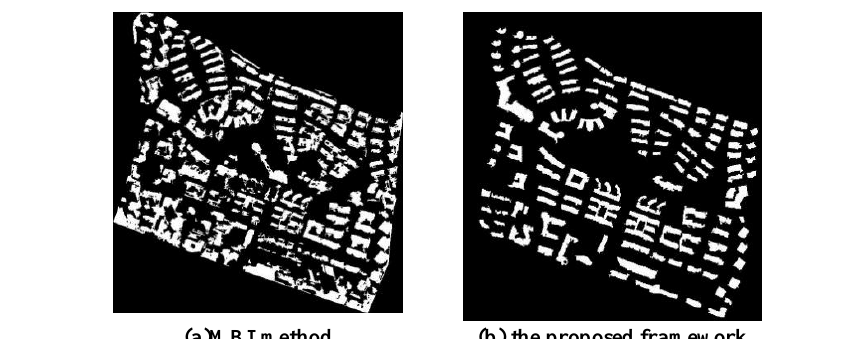
Fig.5 The result of building extraction from GF-1